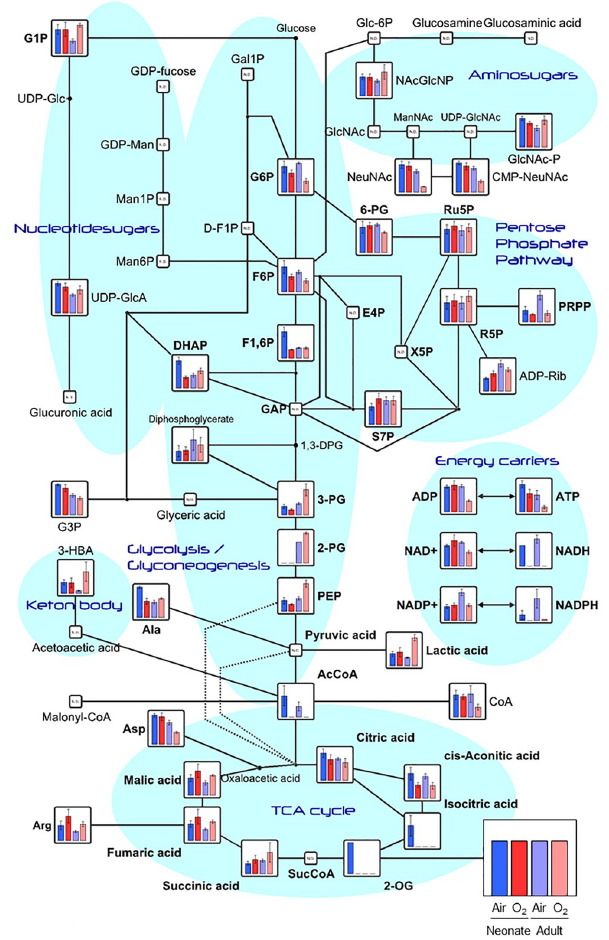
Fig 3. Metabolomic data map of the glycolysis and glyconeogenesis pathways in the neonatal and adult mouse lungs. Vertical axes show the detected average value with standard deviation (error bar) for each comparison, and the groups are arranged from the left in the following order: room air newborn (blue), high O 2 concentration newborn (bright red), room air adult (purple), and high O 2 concentration adult (light red). All metabolic data are presented as means ± standard deviation from biological triplicate